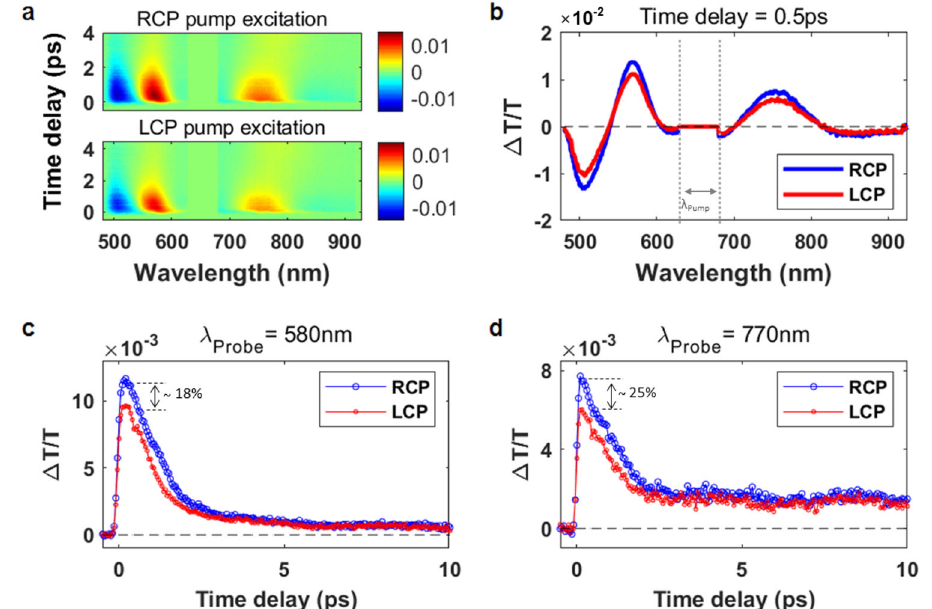
Fig.4|Polarization-dependentbroadbandtransientabsorption(TA)dynamics inchiralgoldnanoparticlearrays.a Time-resolvedTA( Δ T/T)surfacemapsofthe chiral gold nanoparticle array measured with RCP (top) and LCP (bottom) pump beams. b TA spectral cut taken at a pump-probe time delay of 0.5ps under RCP (blue)andLCP (red)pumpillumination.NotethattheTAsignalvaluesintherange